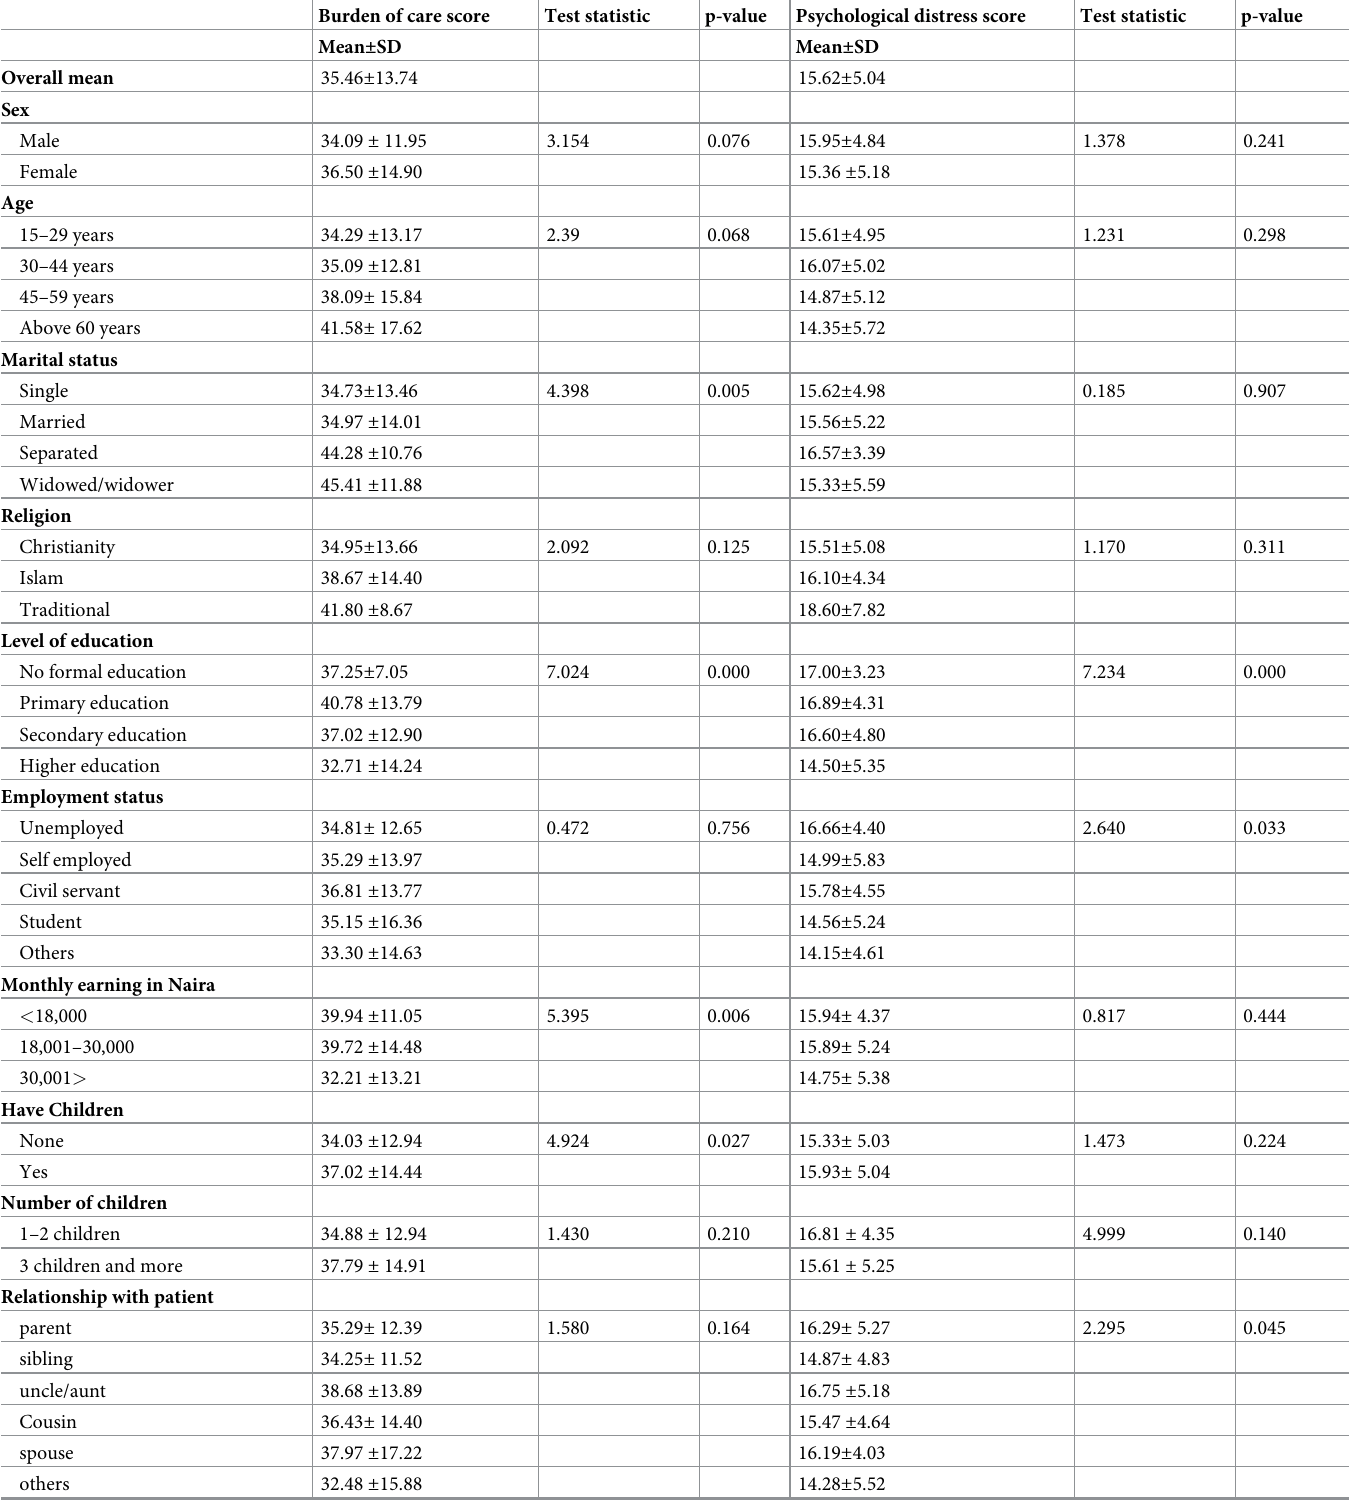
Table 2. Test of difference in mean for burden of care and psychological distress